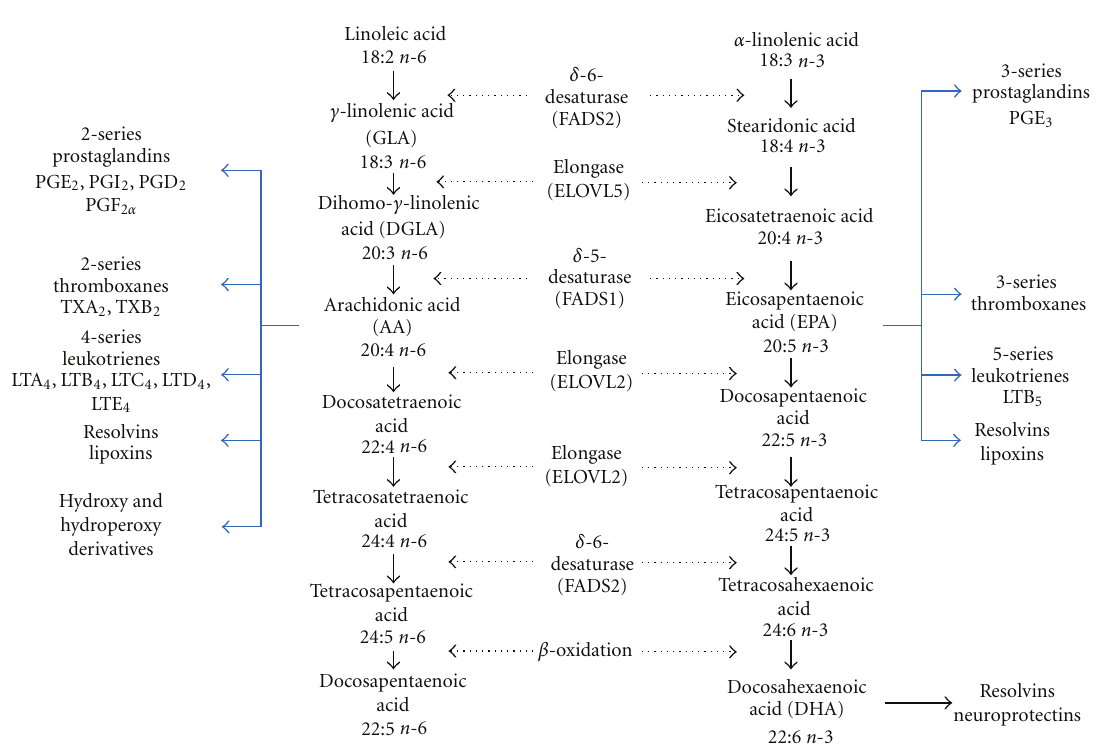
Figure 1: Metabolism of n-6 and n-3 PUFA. The metabolism of PUFA is a complex process involving several enzymes of desaturation, elongation, and β -oxidation. Shown here is the pathway of both n-6 and n-3 PUFA metabolism to more unsaturated, long-chain members of each family. Also shown are their respective eicosanoid derivatives. Data elaborated from